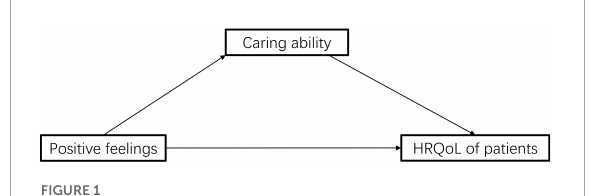
FIGURE1 Schematic diagram of the pathway of positive feelings–caring ability–patient’s quality of life.